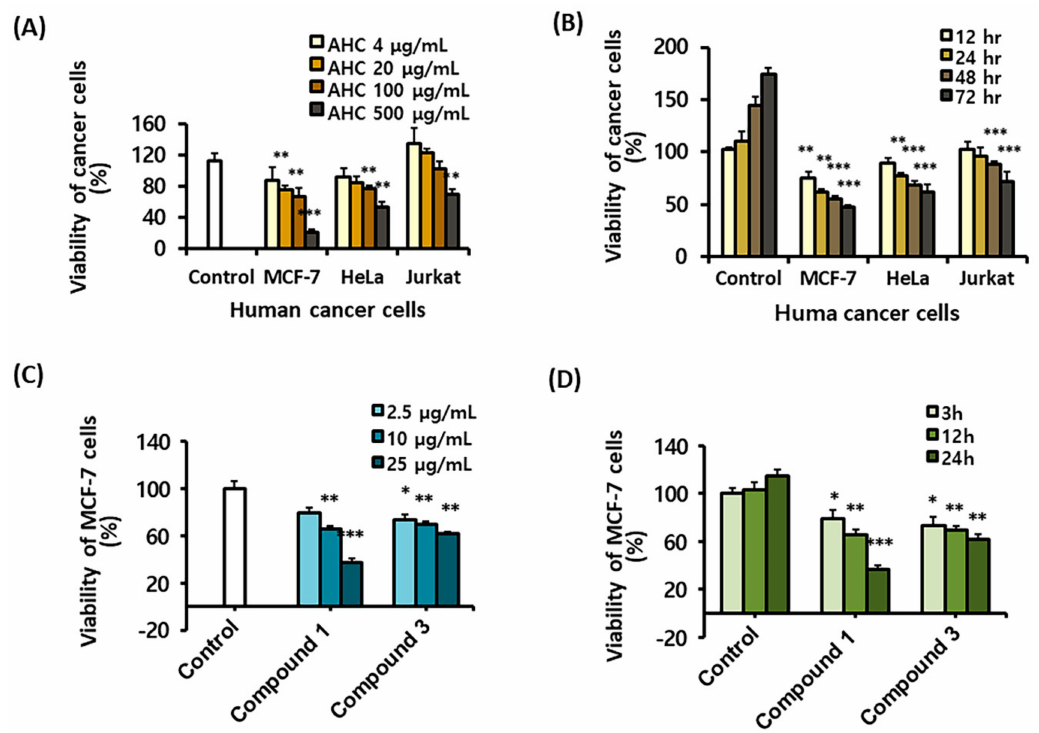
Figure 4. Cytotoxic e ff ects of the AHC extract and the compounds 1 and 3 against various human cancer cell lines. ( A ) Dose dependent e ff ect of AHC after 24 h treatment. ( B ) Time dependent e ff ect of AHC (100 µ g / mL). ( C ) Dose dependent e ff ect of compounds 1 and 3 against MCF-7 cells after 24 h treatment. ( D ) Time dependent e ff ect of compounds 1 and 3 (25 µ g / mL) against MCF-7 cells. Control: 0.1% DMSO in culture medium. Data of * p < 0.5, ** p < 0.05, and *** p < 0.005 vs.